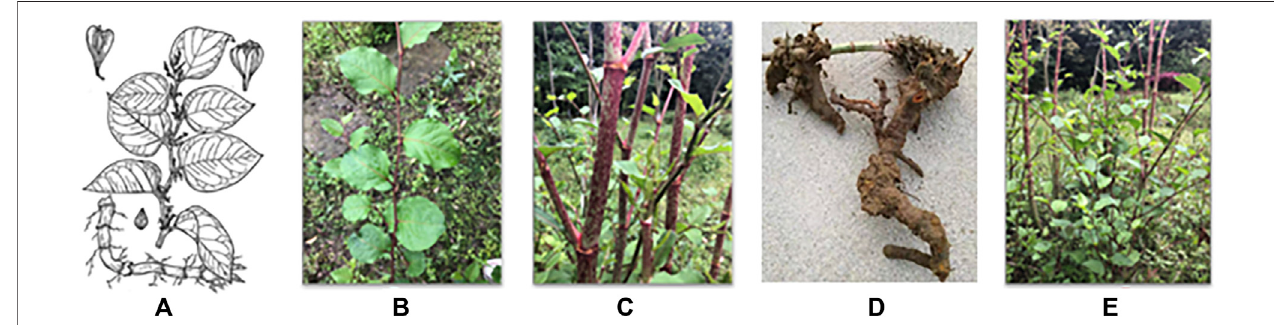
FIGURE 1 | Schematic diagram of HZ herbs. (A) Hand-painted whole-plant image of HZ, (B) HZ leaves, (C) HZ stems, (D) HZ roots and rhizomes, and (E) aerial view of HZ.